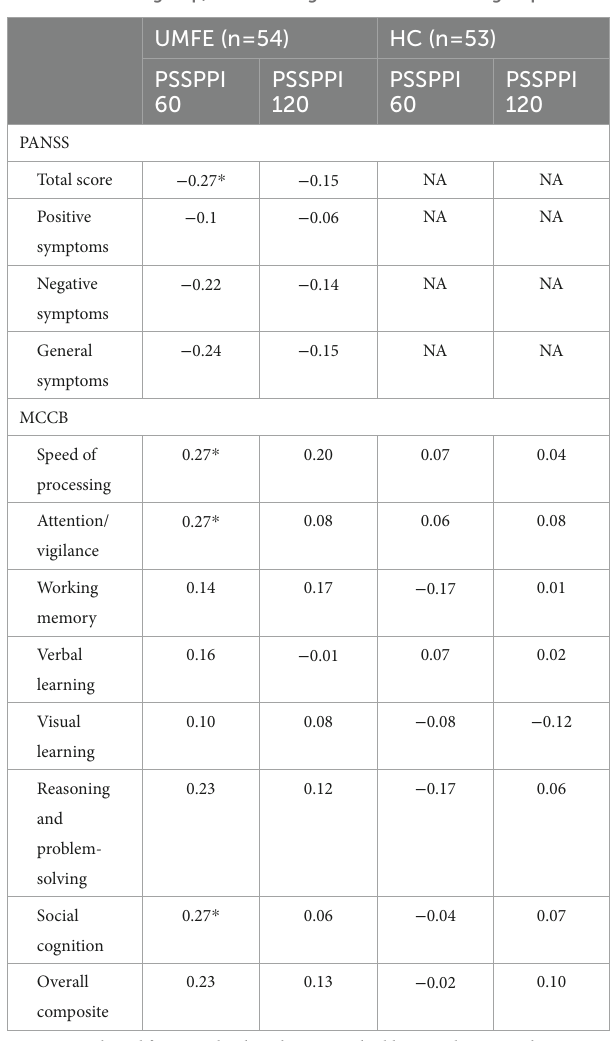
TABLE 3 Correlations between PSSPPI and clinical symptoms/cognitive function in UMFE group, and with cognitive function in HC